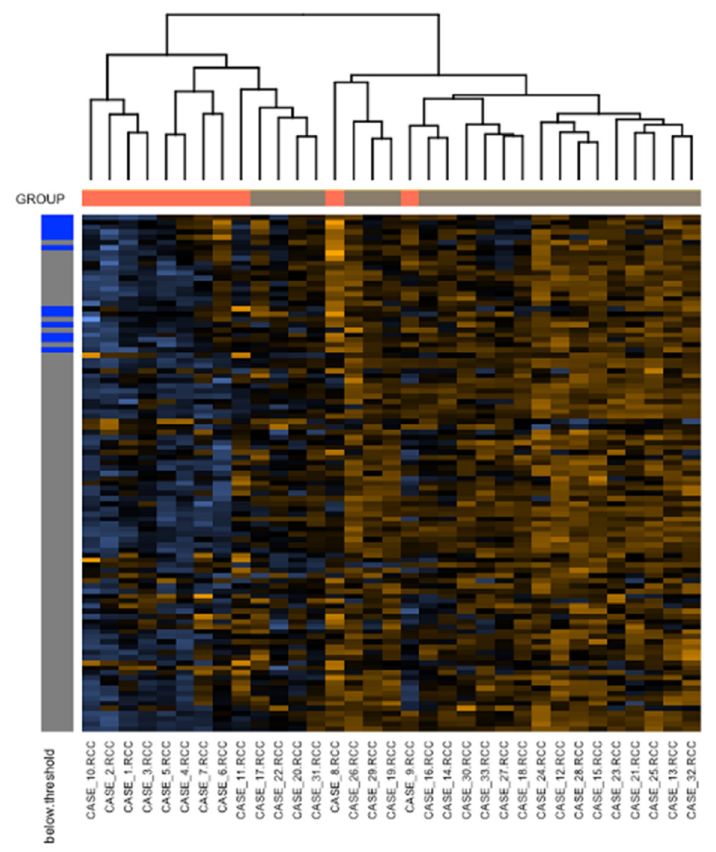
Figure 7. Heatmap representing the normalized genes expression of the cell–ECM interaction pathway. CD4, HLA-A, ITGB2, HLA-E, HLA-DRA, HLA-DPB1, HLA-DPA1, CTSS, PECAM1, HLA-F, HLA-DMB, HLA-DMA, ITGA4, HLA-B, ICAM1, VWF, ARHGDIB, ITGAX, VCAM1, PTPRC, MCAM, ICAM2, EMP3, CD40, TGFB1, HLA-DQB1, PSEN1, CDH5, MMP9, TIMP1, CD34, THBS1, HLA-DRB1, HLA-DRB3 ( p -value < 0.01), CD44, MMP14, COL4A1, and CASP3 ( p -value < 0.05) genes were significantly more expressed. The rows represent the normalized genes (individual genes’ names are not represented here due to space representation issues), the columns the biopsy samples. Within the cells, orange intensity is proportioned to increasing expression of the corresponding gene’s mRNA, while blue intensity is related to lower expression levels. On the left side of the heatmap, genes’ expressions below the detection threshold are represented by blue boxes, while gray boxes represent the ones above the detection threshold. Above the heatmap, orange boxes represent the control group cases, while gray boxes the c-ABMR cases. The dendrogram represents levels of interdependence among cases.